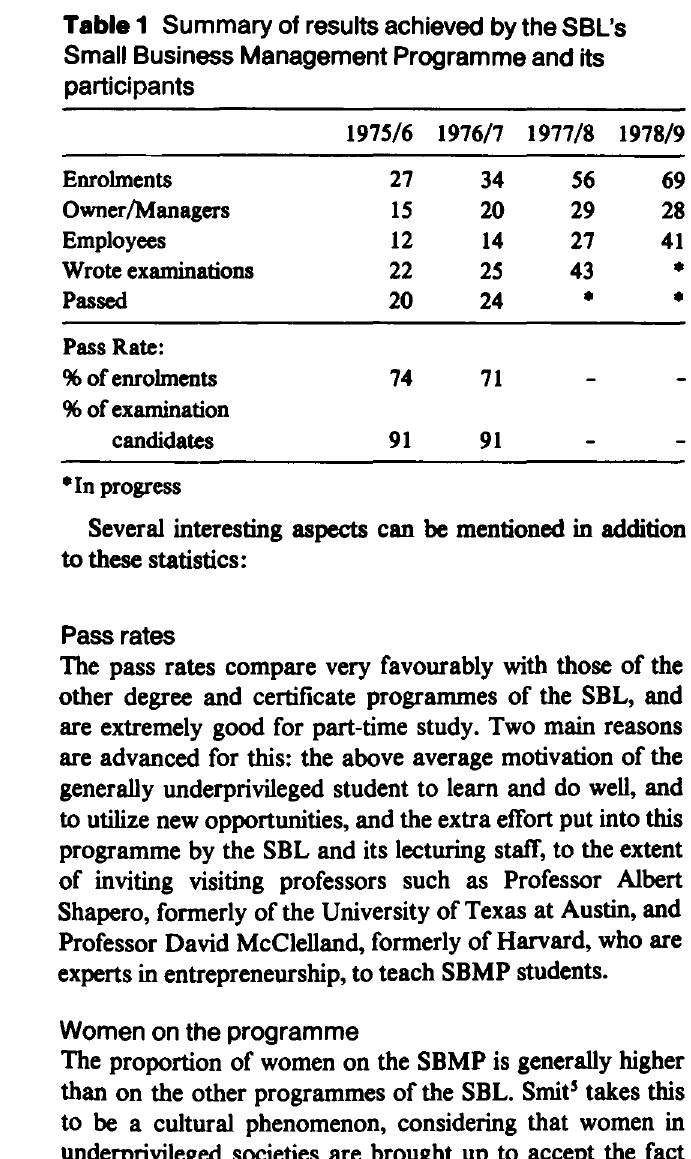
Table 1 Summary of results achieved by the SBL's Small Business Management Programme and its